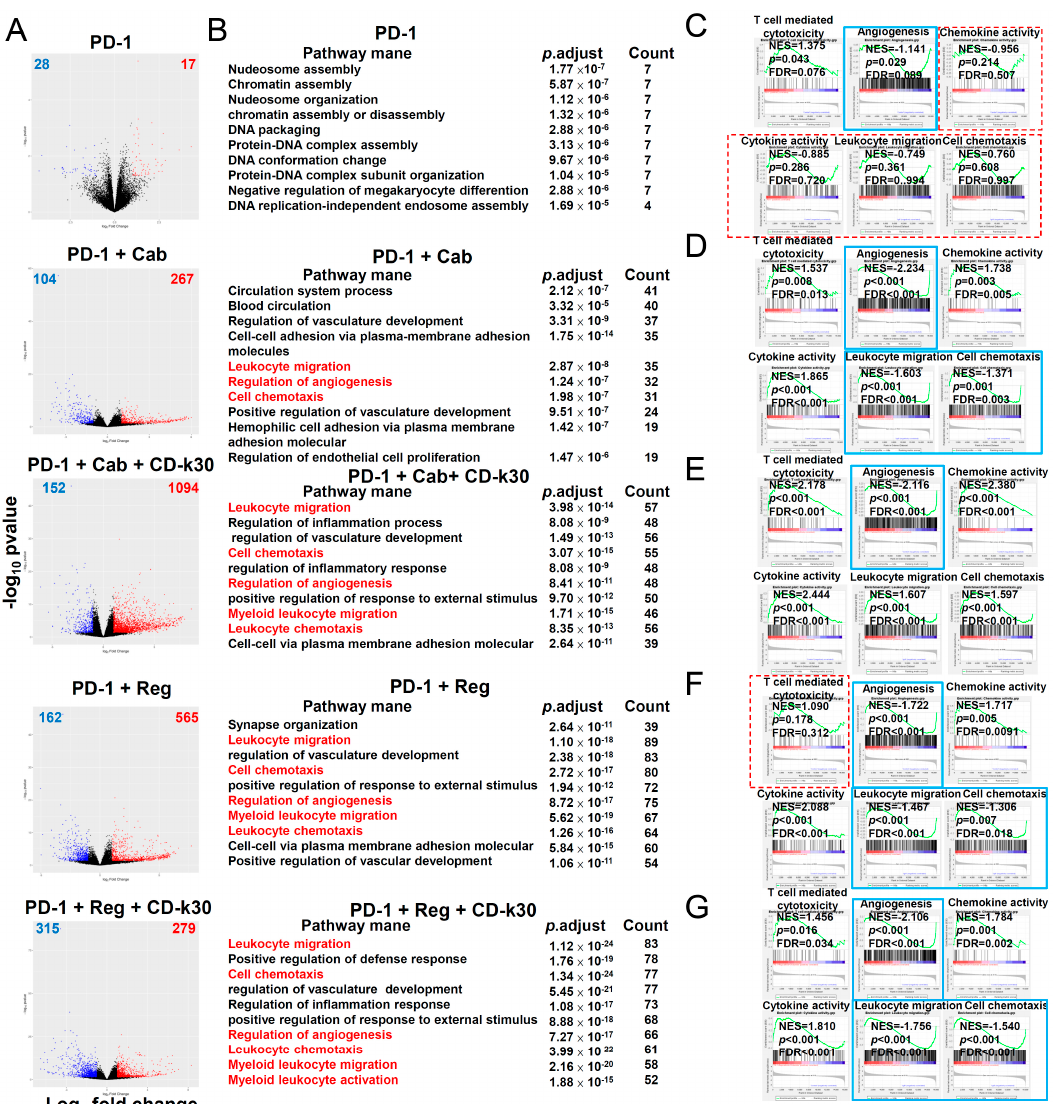
Figure 3. Identification of target genes of anti-PD-1 Ab combined with Regorafenib/Cabozantinib plus Chidamide-k30 treatment, which significantly regulates gene expression in TME of CT26 tumors-bearing mice. Tumors were analyzed on day 20 after 9-day treatment for gene expression by RNA-seq. ( A ) Volcano plot of differentially expressed genes obtained by RNA-seq analysis in anti-PD-1 Ab combined with Regorafenib/Cabozantinib plus Chidamide-k30 treatment CT26 tumors compared to IgG control tumors. Significantly upregulated or downregulated genes are plotted in red and blue points, respectively. ( B ) Meta-enrichment analysis summary for significantly upregulated and downregulated genes was indicated by display of categories of related pathways and the number of affected genes of the corresponding pathway. The pathways highlighted with red color were related to the gene expression signatures in ( C – G ). ( C – G ) show that gene expression related to chemokine activity, cytokine activity, leukocyte migration, cell chemotaxis, T-cell-mediated cytotoxicity and angiogenesis were analyzed in tumors. ( C ) GSEA enrichment analysis of tumors treated with anti-PD-1. ( D ) GSEA enrichment analysis of tumors treated with PD-1 + cab. (E ) GSEA enrichment analysis of tumors treated with anti-PD-1 + Cab + CD-k30. (F) GSEA enrichment analysis of tumors treated with anti-PD-1 + Reg. ( G ) GSEA enrichment analysis of tumors treated with anti-PD-1 + Reg + CD-k30. NES: normalized enrichment score; FDR: false discovery rates. Signature scores were calculated by mean log2 (TPM) of their respective member genes; p -values: Mann-Whitney test, two-tailed. When p ≧ 0.05, the GSEA analysis panel(s) is outlined with a red dotted line. When gene expression was downregulated, the GSEA analysis panel(s) is outlined with a blue solid line.